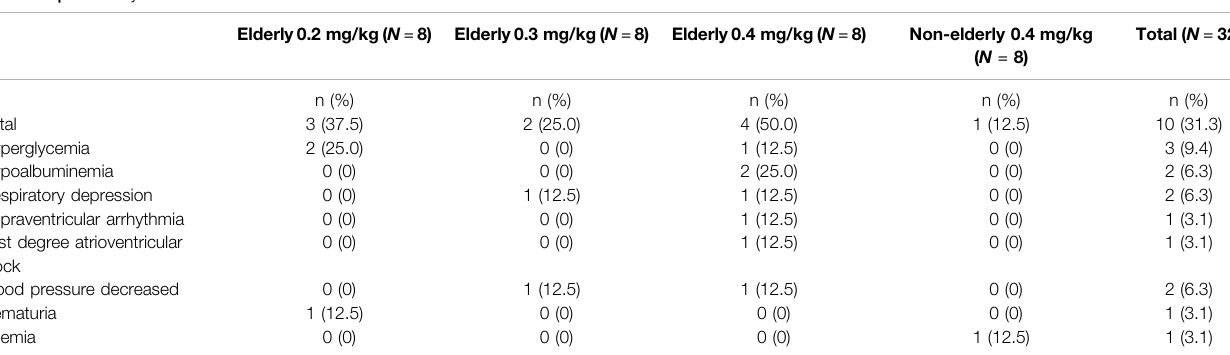
TABLE 2 | Summary of adverse